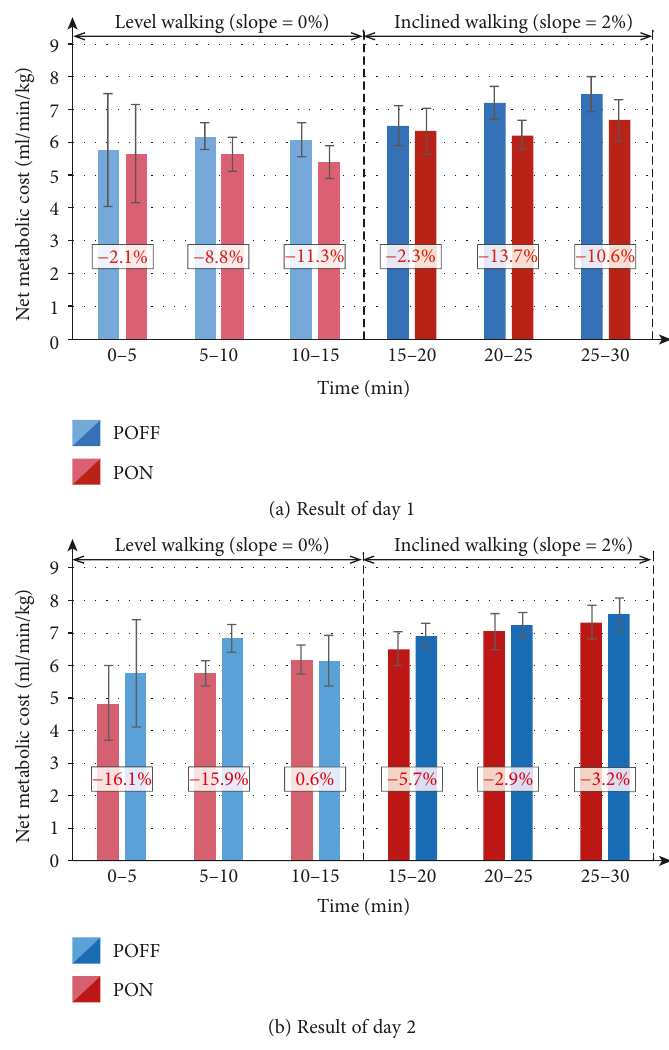
Figure 6: Comparison of metabolic cost between the POFF condition and the PON condition for 5-minute intervals. On each bar chart, the error bar denotes standard deviation. In addition, the number expressed in percentage represents the di ff erence of the PON condition compared with the POFF